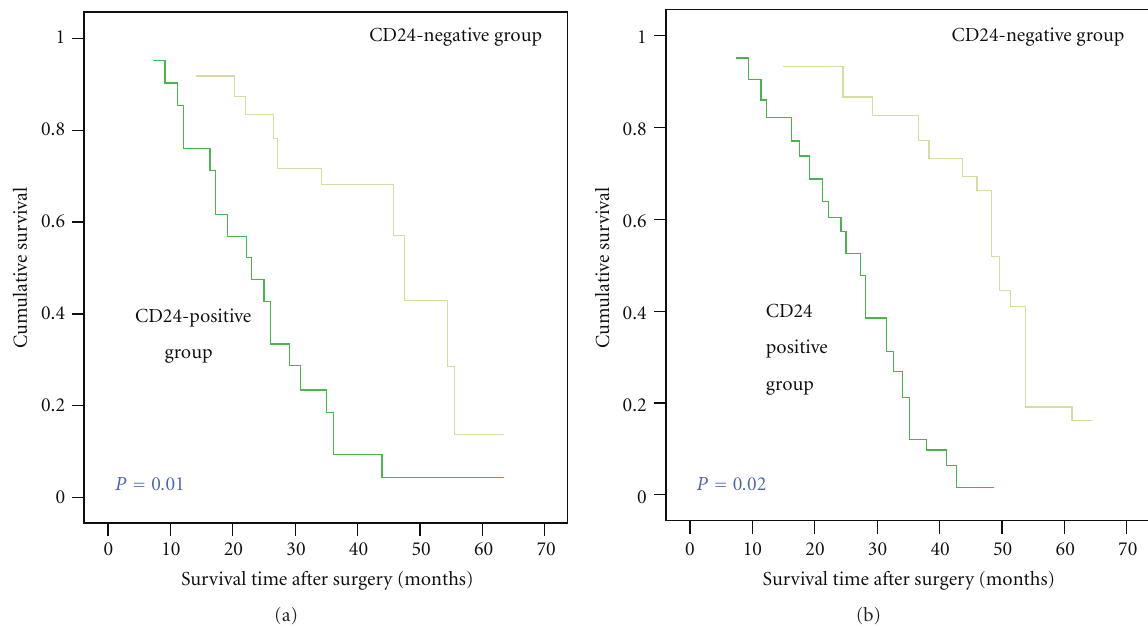
Figure 2: Postoperative survival curves for patterns of patients with glioma and CD24 expression. (a) Kaplan-Meier postoperative survival curve for patterns of patients with glioma and CD24 expression. Unadjusted RR of CD24-negative and -positive groups were 1.0 and 0.02, respectively ( P = 0 . 01). (b) Cox proportional hazards model after adjusting for age, gender, and grade. CD24 might be an independent predictor of survival, without consideration of age, gender, or grade. Adjusted RR of CD24-negative and positive groups were 1.0 and 0.04, respectively ( P = 0 . 02).